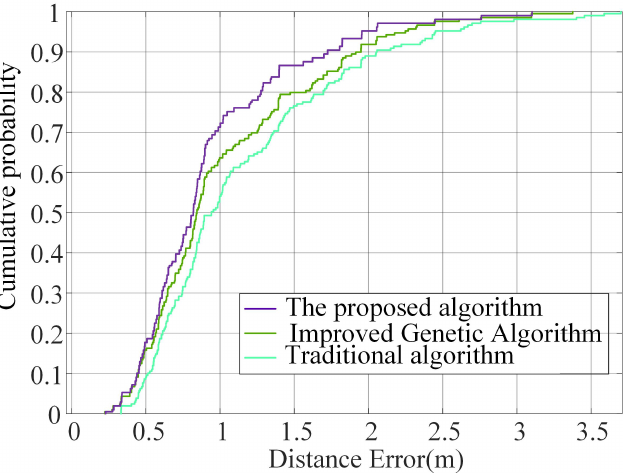
Figure 9. Comparison of different line-of-sight path-based positioning algorithms.